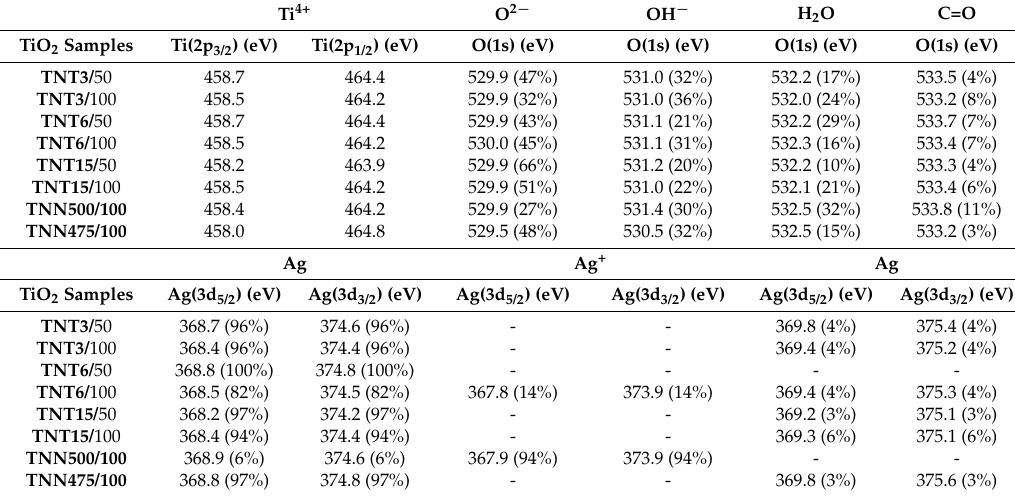
Table 1. XPS data of TNT/Ag